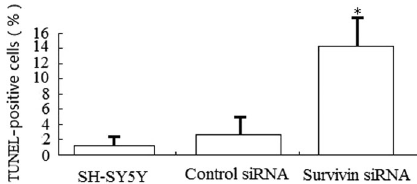
Figure 4. Influence of survivin knockdown on cell apoptosis. TUNEL staining was used to detect apoptosis in SH-SY5Y cells after transient survivin siRNA and control siRNA transfection for 48 h. Data are reported as means±SD. *P , 0.05, compared with